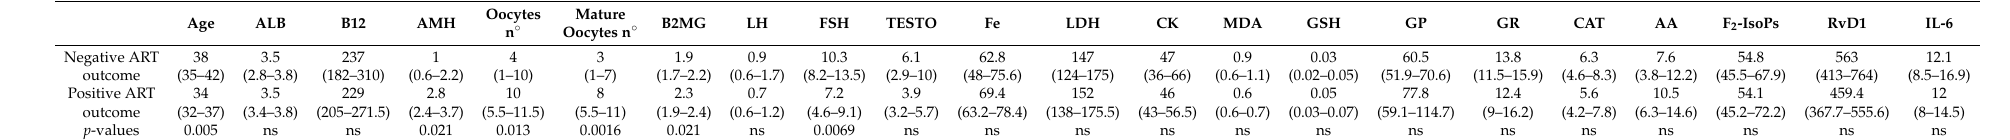
Table 2. Medians and 25 ◦ –75 ◦ centiles (in parenthesis) of age, albumin (ALB), vitamin B12 (B12), anti-Müllerian hormone (AMH), number of oocytes, number of mature oocytes, beta-2-microglobulin (B2MG), luteinising hormone (LH), follicle stimulating hormone (FSH), testosterone (TESTO), iron (Fe), lactate dehydrogenase (LDH), total creatine kinase (CK), malondialdehyde (MDA), glutathione (GSH), glutathione peroxidase (GP), glutathione reductase (GR), catalase (CAT), ascorbic acid (AA), F 2 -isoprostanes (F 2 -IsoPs), resolvin (Rv)D1, and Interleukin-6 (IL-6) assayed in follicular fluids of 72 infertile women divided into 2 groups according to the assisted reproduction techniques (ART) outcome (negative, positive). In the last row, for each variable, the p -value of the Wilcoxon test. When p -value is greater than 0.05, ns, which stands for not significant, is